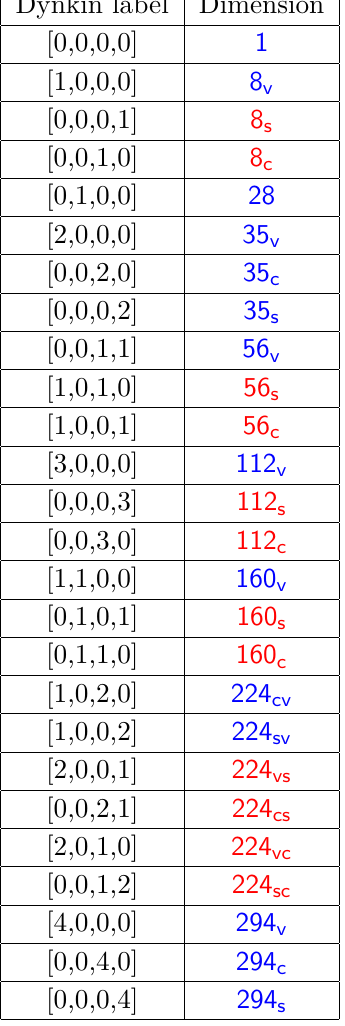
Table 4 . so (8) irreducible representations #1